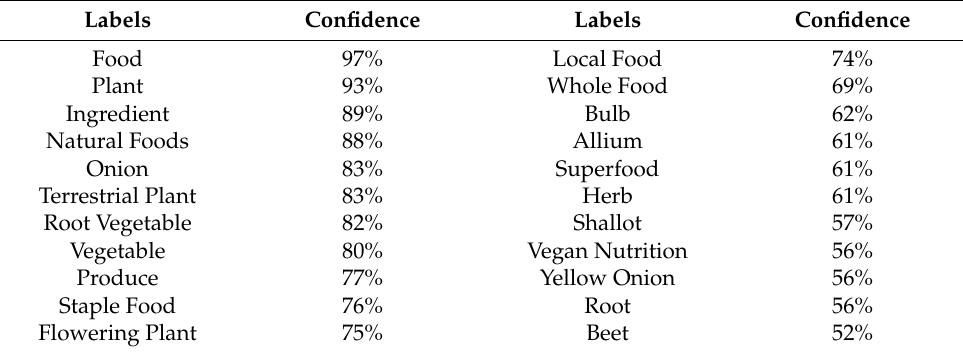
Table 2. Labels based on Google Vision (example for an image of an onion).